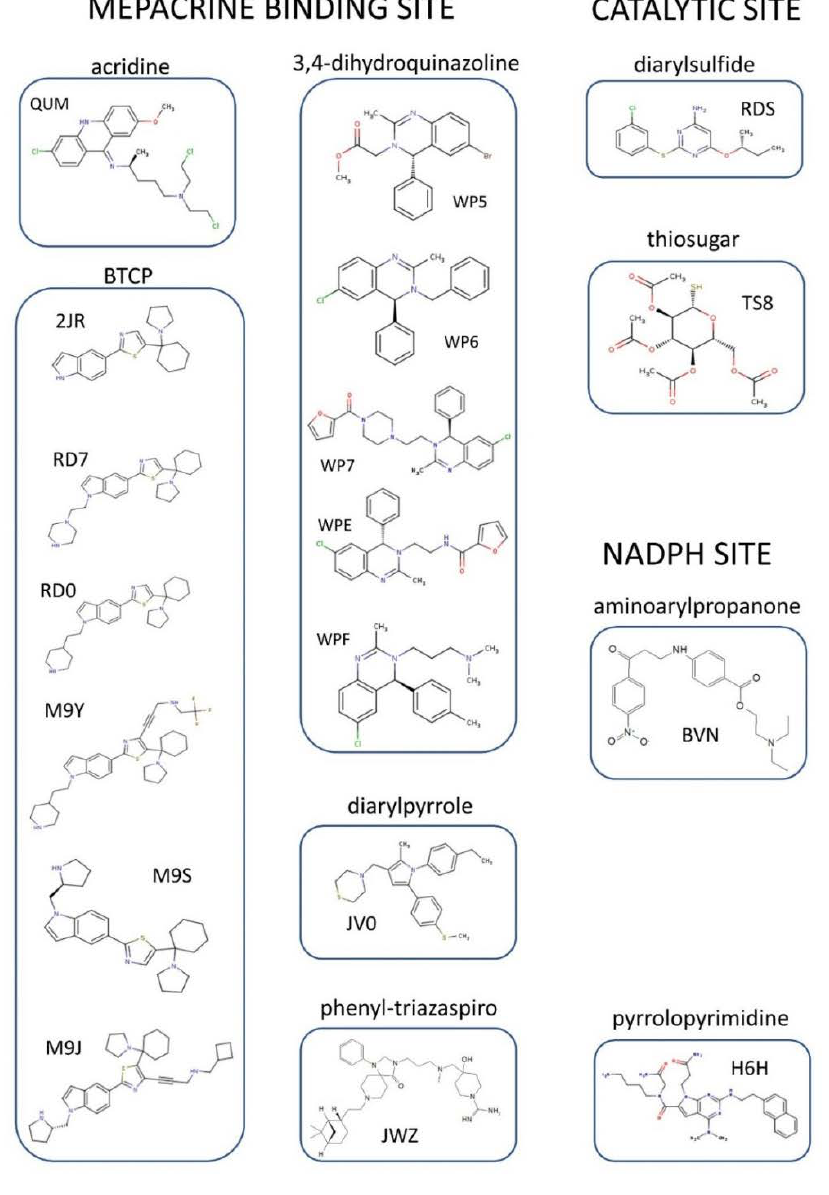
Figure 3. Organic inhibitors co-crystallized with TR, grouped by binding site and molecular scaffold. Molecules are named by PDB 3-digit ID. Table 1. All inhibitors co-crystallized with TR.